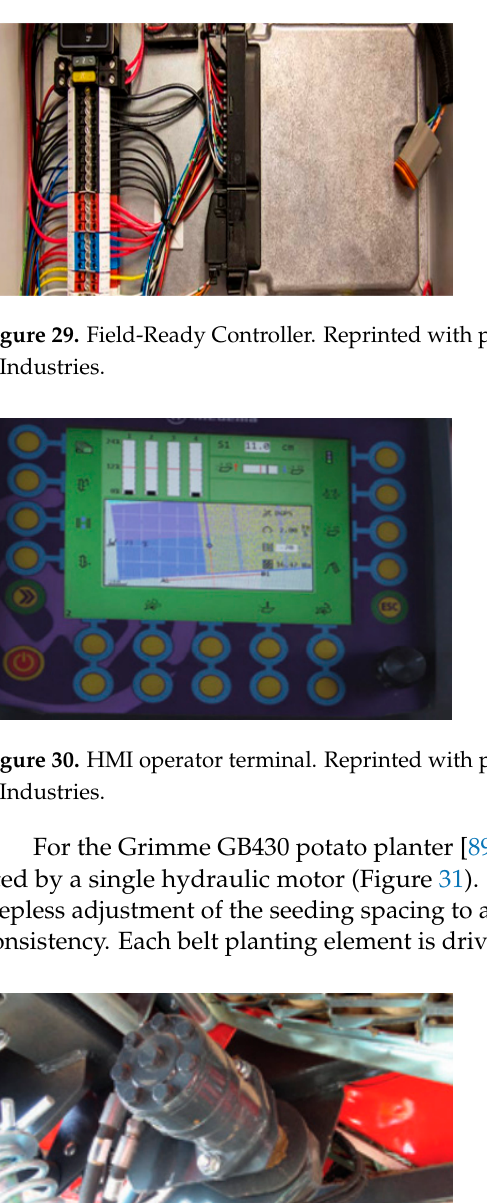
Figure 31. Hydraulic drive motor. Reprinted with permission from ref. [90] Copyright 2022 Grimme Industries.